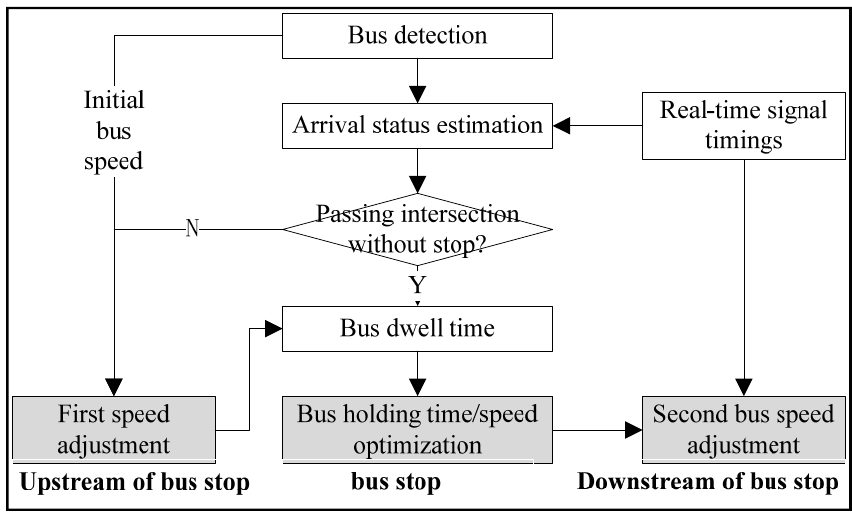
Figure 2. Framework of the EDTV